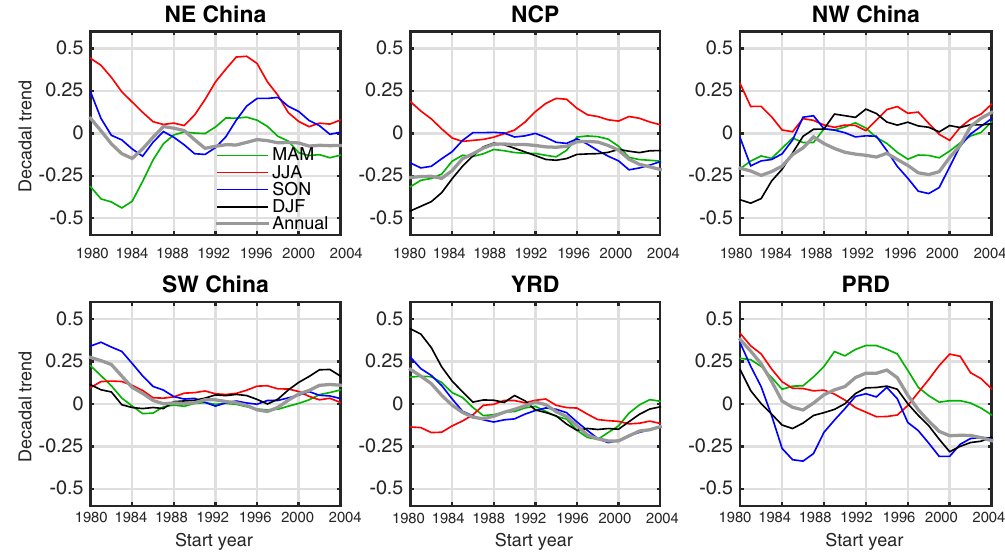
Figure 4. Seasonal time series of the difference between the extreme and median trends. The trends are calculated for each 10-year period starting from 1980 to 2004 ( x axis), i.e., the first point is the trend difference for the 1980 to 1989 period, the second from 1982 to 1990,